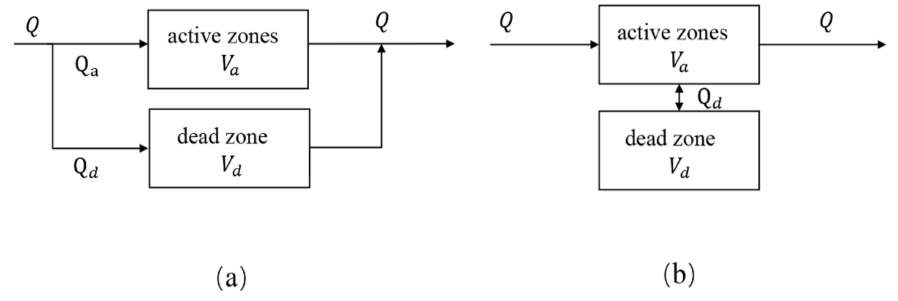
Figure 2. Two combined models ( a ) Moving dead zone ( b ) Stagnant dead zone